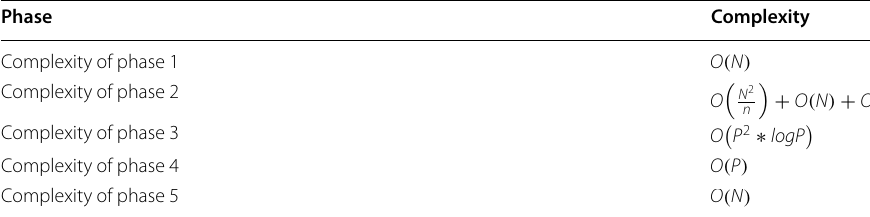
Table 2 Complexity of the algorithm phases